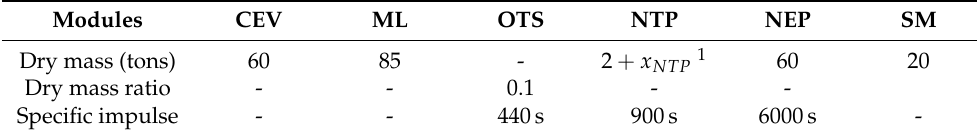
Table 4. The basic parameters of all considered